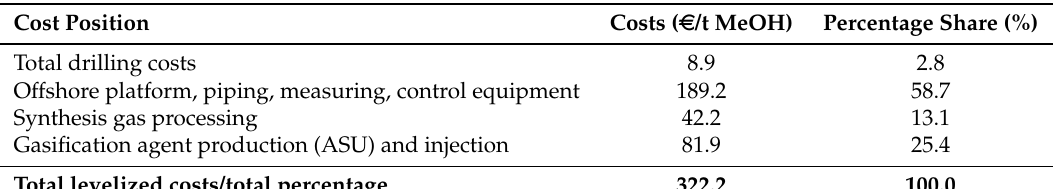
Table 14. Share of individual cost positions on levelized offshore UCG-based methanol production costs for 20 years of operation.